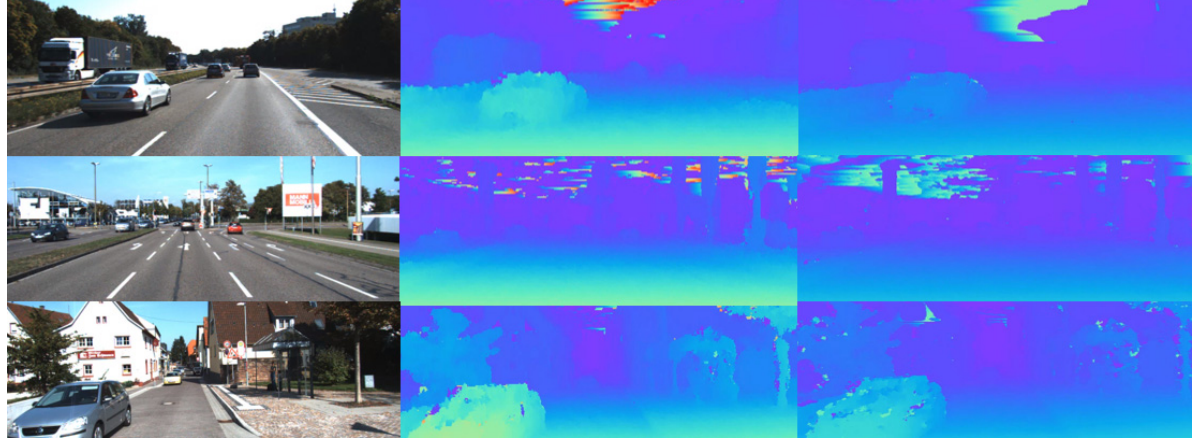
Figure 4. KITTI 2015 test set: ( left ) original images, ( center ) depth map images obtained using proposed algorithm, ( right ) depth map images obtained using Luo et al.’s algorithm.